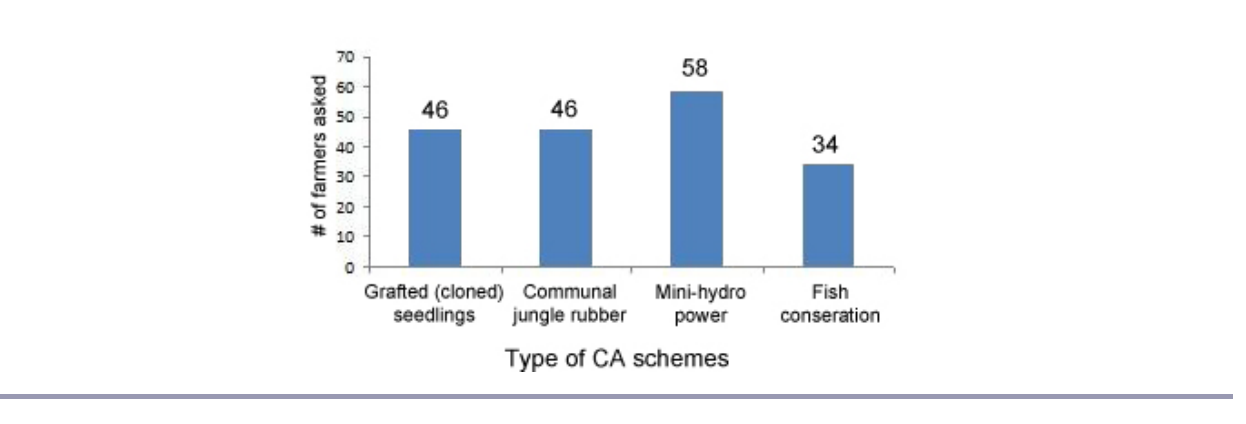
Fig. 5. Preferred conservation agreement (CA) schemes, 2010 in Jambi